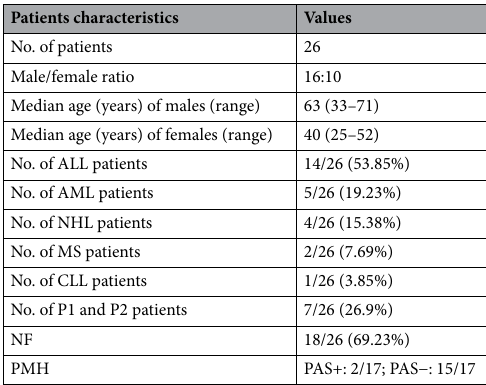
Table 1. Characteristics of the study participants. ALL acute lymphoid leukemia, AML acute myeloid leukemia, NHL non-Hodgkin lymphoma, MS myeloid sarcoma, CLL chronic lymphocytic leukemia, P1